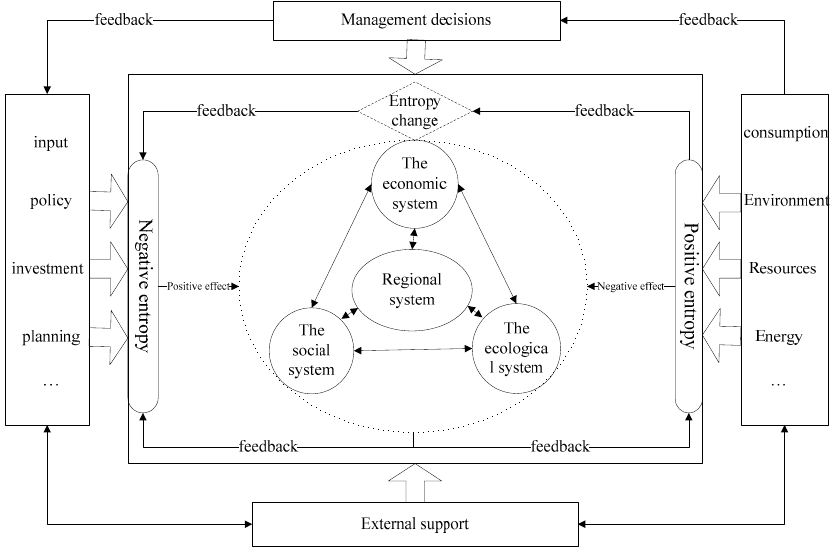
Figure 2. The framework for regional system development.